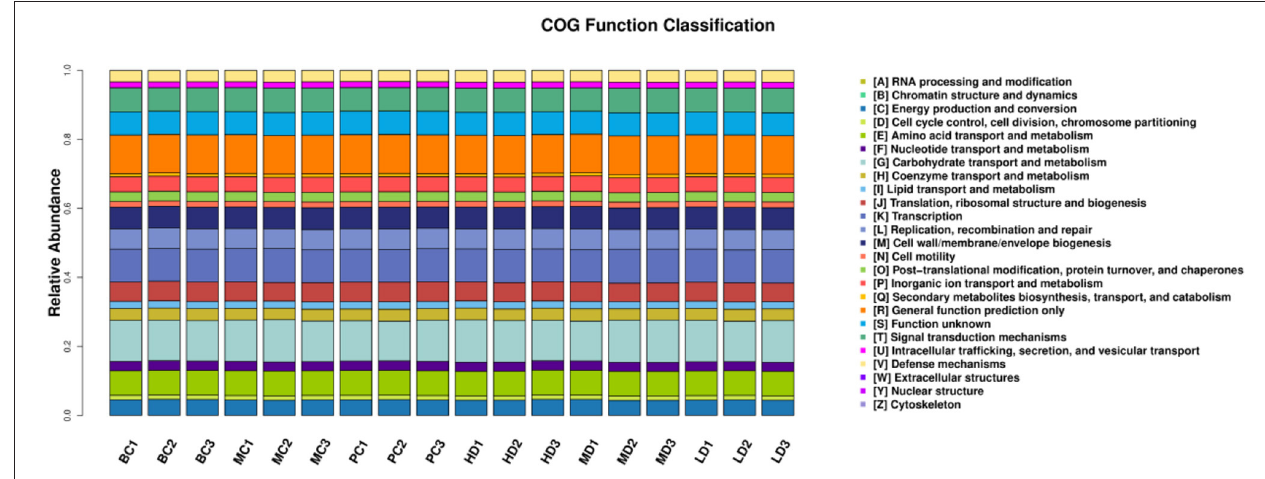
FIGURE 10 | Bar distribution of COG functional abundance.